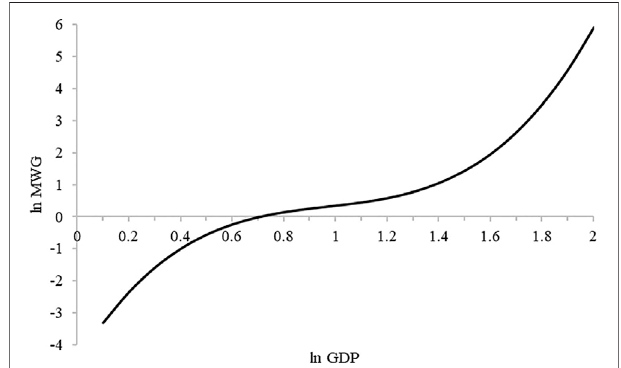
FIGURE 4 | EKC curve between GDP per capita and